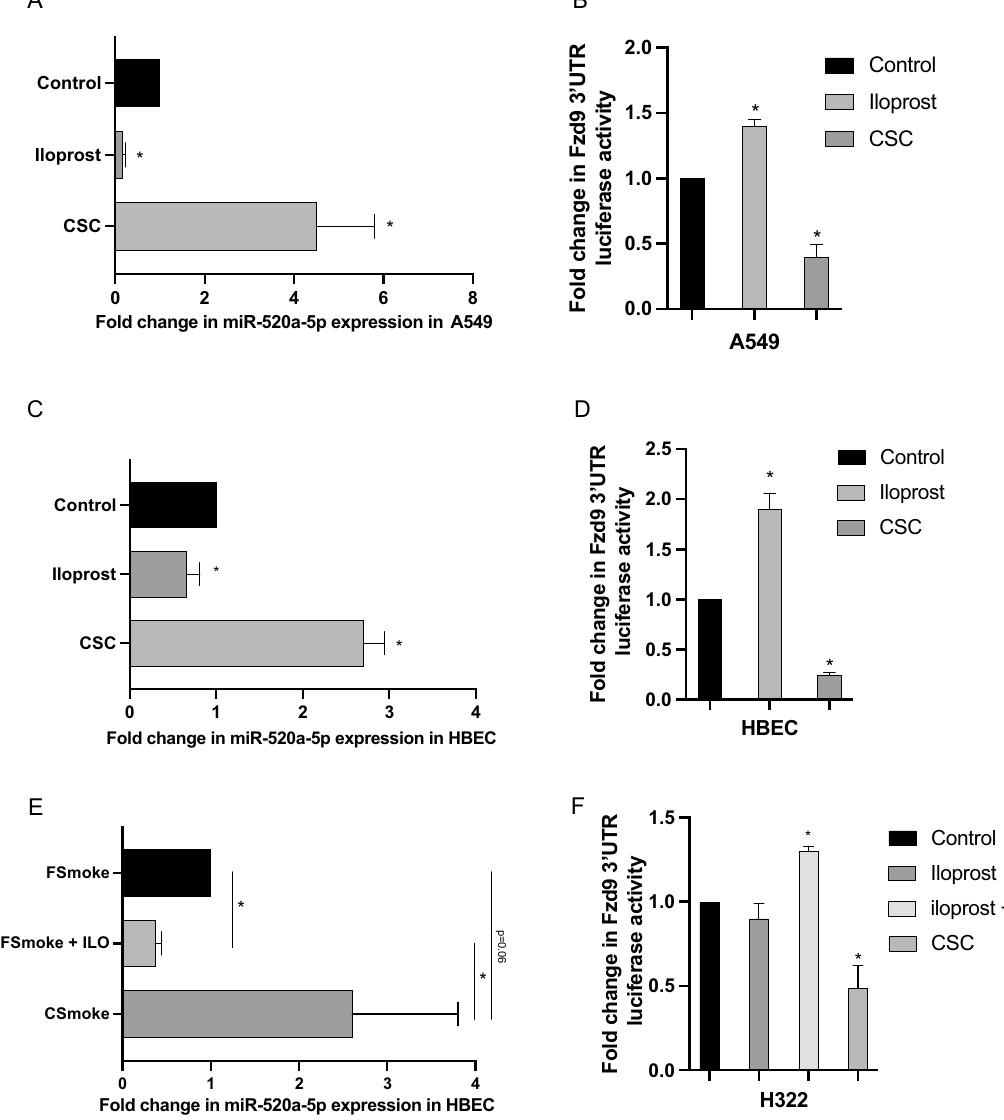
Figure 4. CSC and iloprost alter miR-520a-5p expression and FZD9 3’UTR activity. miR-520a-5p expression ( A , C ) and transfected FZD9 3’UTR luciferase activity ( B , D ) in A549 and HBEC cell lines after 48 h treatment with 5 µg/ml (HBEC) or 20 µg/ml (A549) CSC or 10 µM iloprost. ( E ) miR-520a-5p expression in the HBEC cell line treated with four weeks of 5 µg/ml CSC, followed by four weeks of removal of CSC (FSmoke), removal of CSC and addition of 10 μM iloprost (FSmoke + ILO), or continued CSC (CSmoke). (F) FZD9 3’UTR luciferase activity in the H322 cell line after transfection with FZD9 plasmid and 48 h treatment with 20 µg/ml CSC or 10 µM iloprost. Luciferase activity was measured in duplicate and show relative to control. miRNA expression was measured in triplicate by qPCR, normalized to RNU6, and shown relative to control. * p < 0.05 versus